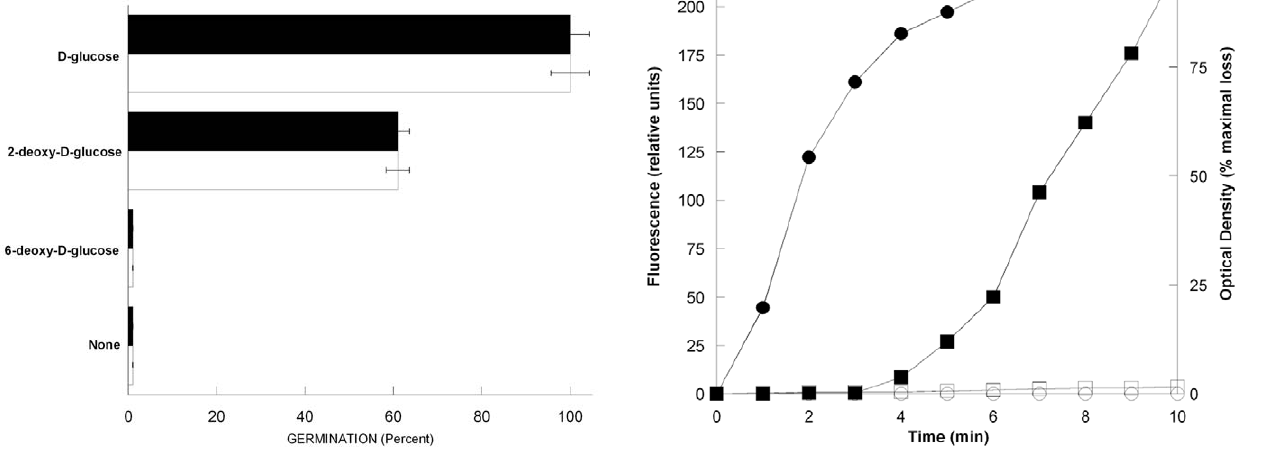
Figure 3. Germinant Specificity of F-spores. B. megaterium F- spores (constructed with diacetylfluorescein) were exposed to 4 mM of the indicated D-glucose derivatives at 37 u C for 20 min. Fluorescence: Black bars. Optical density loss: White bars. Fluorescence and optical density loss were measured as indicated in Materials and Methods. Data were normalized using as 100% the values of F-spores induced to germinate by D-glucose. Error bars indicate SD of the mean. doi:10.1371/journal.pone.0009283.g003 PLoS ONE |